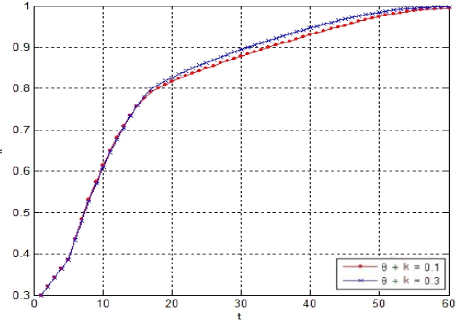
Figure 7. The influence of ( θ + k) changes on the probability of government inspections, x.